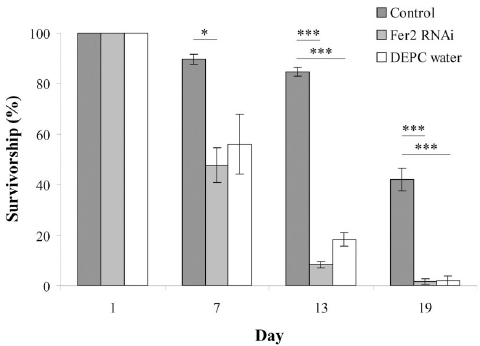
Fig 1. The survivorship of worker bees injected with ferritin2 dsRNA or DEPC water at 1, 7, 13, and 19 days after adult emergence. Control, no injection. Fer2 RNAi, ferritin2 dsRNA injection. DEPC water, DEPC water injection. The results were expressed as percentages and presented as the means at 1 day and as the means ± standard error of the means (SEMs) at 7, 13, and 19 days ( n = 210). Asterisks indicate statistical significance ( � P < 0.05; ��� P < 0.001; one- way